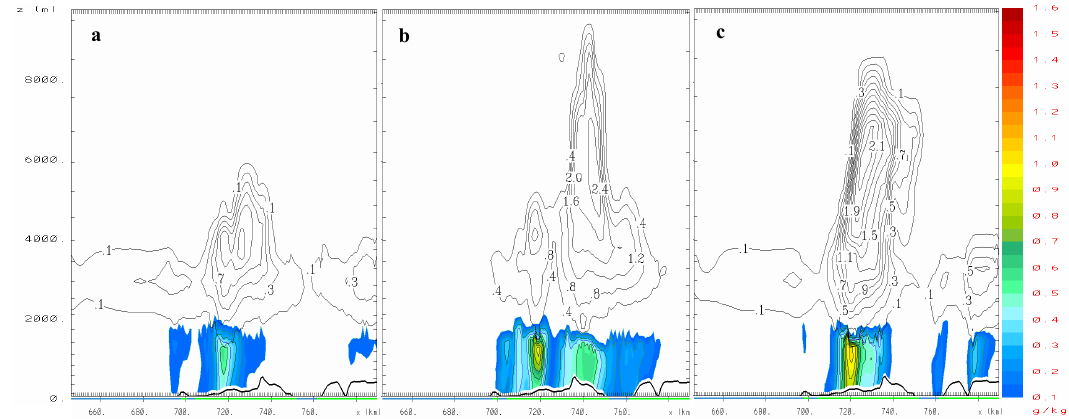
Fig. 6. West to East cross-section of rain mixing ratio (color palette in gkg − 1 ) and ice mixing ratio (black line contours in gkg − 1 ) at the time of highest cloud top over Haifa. (a) 09:00 UTC, 29 January 2003 assuming 5% hygroscopic dust. (b) 10:00 UTC, 29 January 2003 assuming 20% hygroscopic dust. (c) 09:00 UTC, 29 January 2003 assuming 5% hygroscopic dust and number of ice nuclei increased by a factor 10. (Adopted from Solomos et al.,